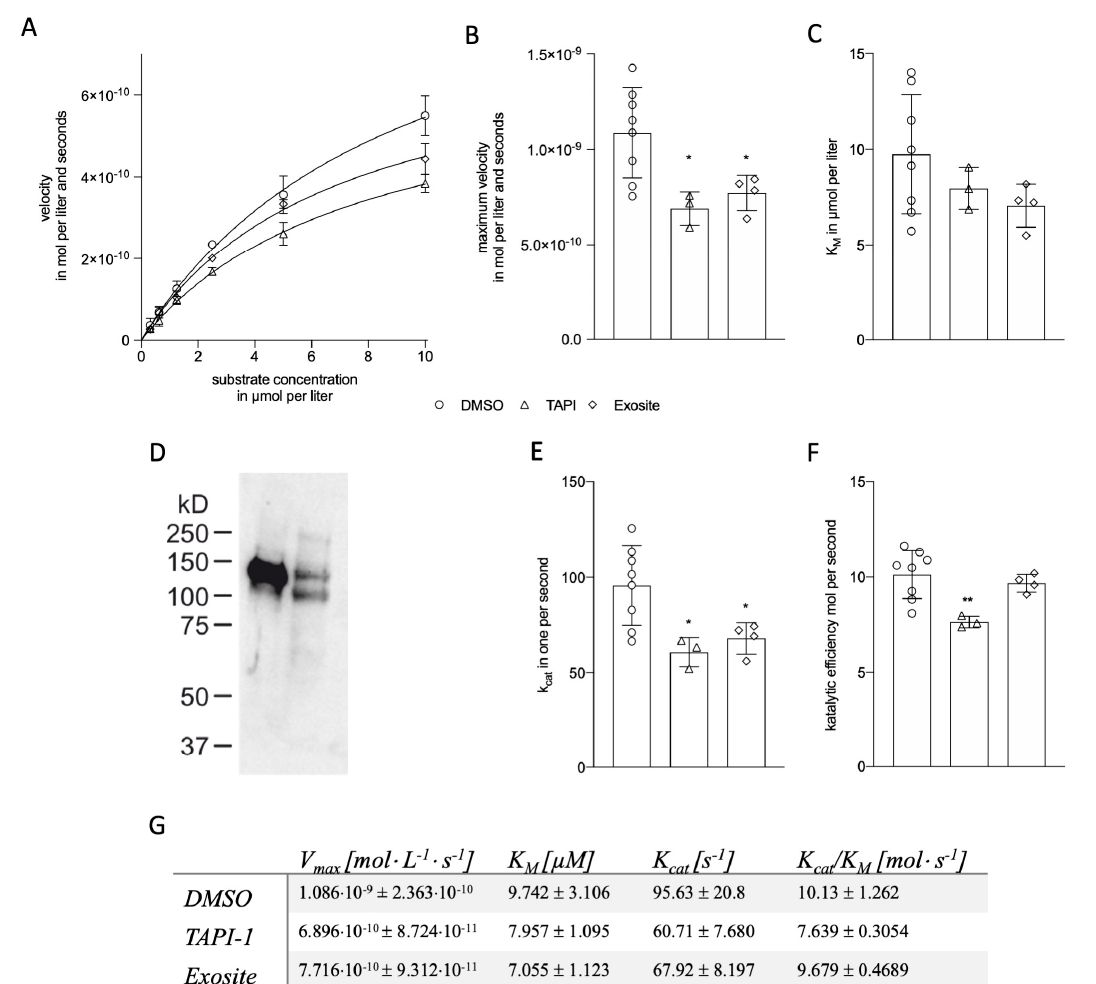
Figure 2. Kinetic modeling of ADAM17 inhibitors. To determine V max and K M , HEK cell lysates were probed for cleavage of varying substrate concentrations (0 to 10 µ M, ( A )). V max ( B ) and K M ( C ) were calculated using Michaelis-Menten curve fitting. ( D ) HEK cell lysate (lane 2) was analyzed for the expression of ADAM17 pro-form (130 kDa) and mature form (100 kDa) by Western blot. As a control, HEK cells overexpressing ADAM17 (lane 1) were used. K cat ( E ) and the efficiency ( F ) were calculated from the obtained values. Experimental kinetic data are summarized in ( G ). Data are shown as mean ± SD of at least three independent experiments. Statistical significance was analyzed using one-way ANOVA and Dunnet’s post-hoc test for multiple comparisons (* p < 0.05, ** p < 0.01).